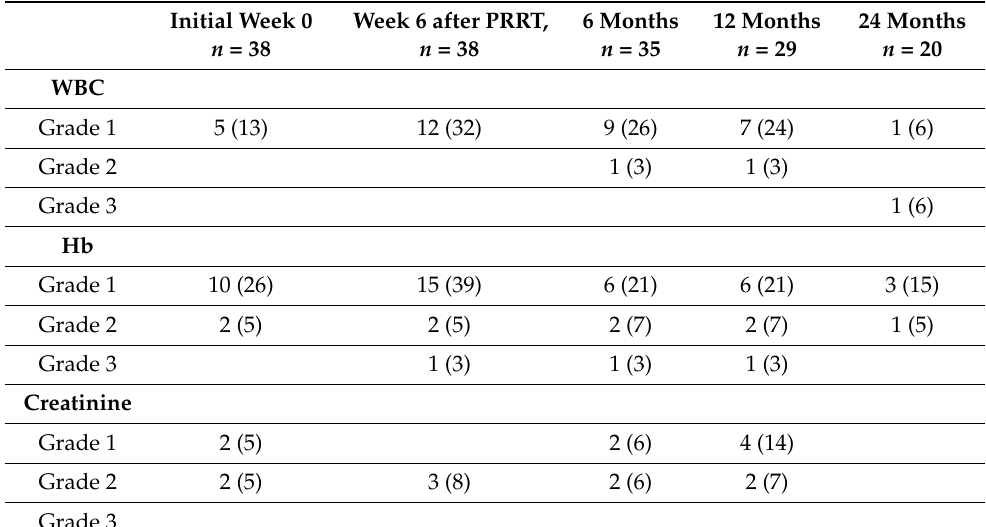
Table 5. Treatment-related hematological and kidney adverse events (AEs) in the whole group of treated patients, percentages in